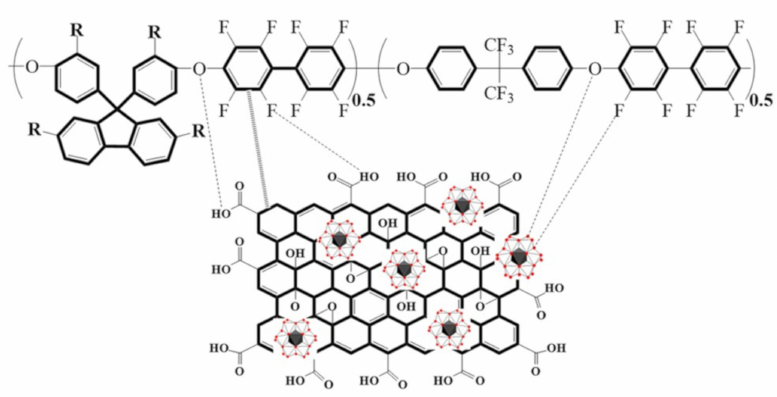
Figure 1. Structure of SPAE/GO/PWA composite